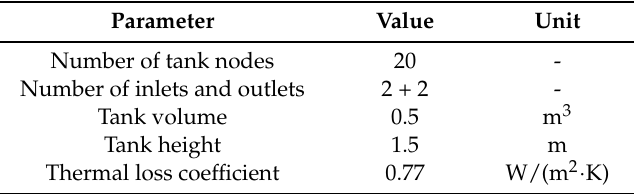
Table 6. Cold water storage tank (CST) parameters.